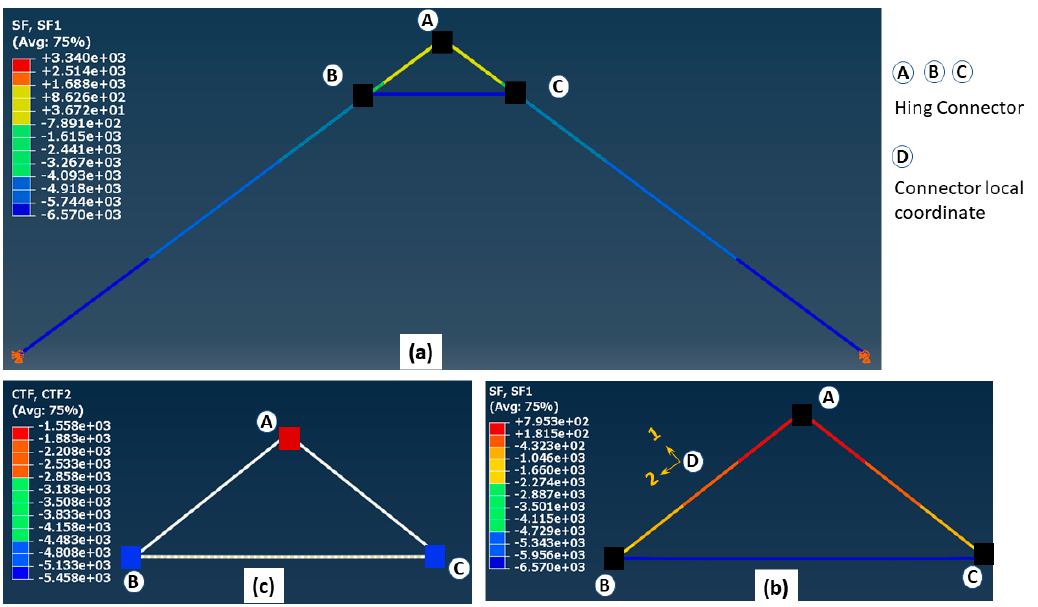
Figure 18. ( a ) Axial forces in the 2D assembly, ( b ) axial force in the apex connection, and ( c ) forces in the pins of apex connection (unit in the figure is N).